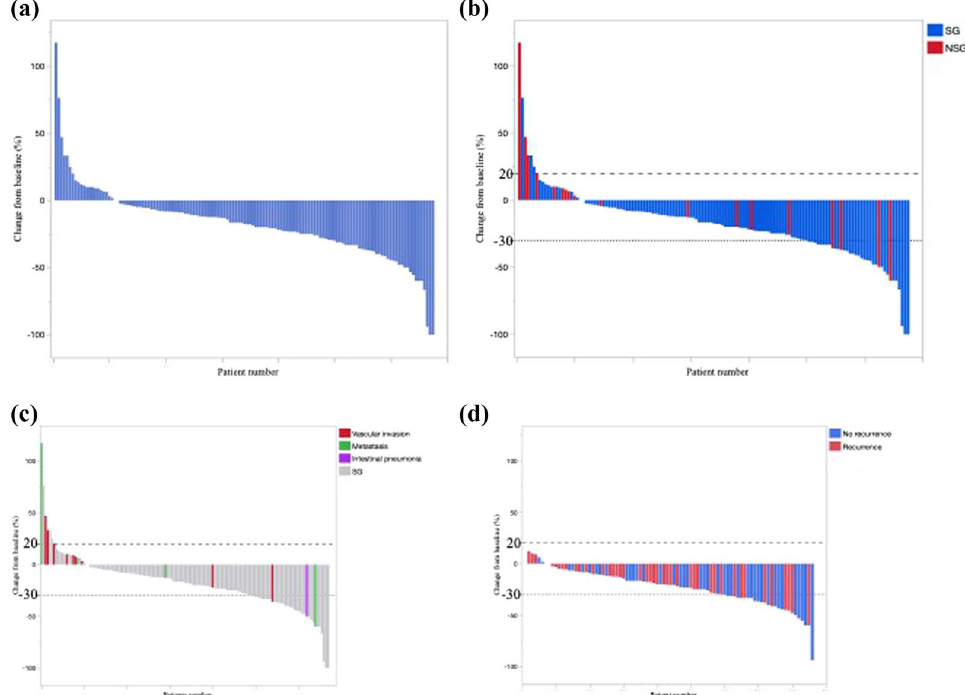
Fig. 3 Waterfall plot of tumor response for each patient with imaging performed before and after neoadjuvant chemotherapy (NAC) (n = 135). a Total 112 patients (83.0%) experienced tumor shrinkage. b Relationship between tumor response and operability after NAC. One-third of the patients in the non-surgical group experienced tumor shrinkage. c Relationship between tumor response and unresect- able reasons. Importantly, metastases developed even in patients with shrinkage of the primary tumor by NAC. d Relationship between tumor responses and recurrences in the SG-2 * . Recurrence is associated with tumor shrinkage after NAC. NAC neoadjuvant chemotherapy, SG surgical group, NSG non-surgical group. *SG-2: patients with pancreatic ductal adenocarcinoma received NAC with gemcitabine plus nab-paclitaxel following R0/R1